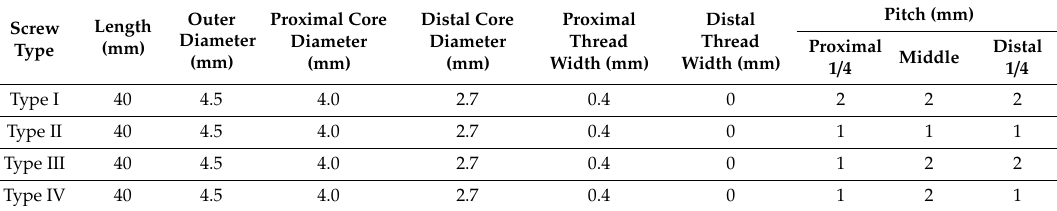
Table 1. Dimensions of the examined screws.